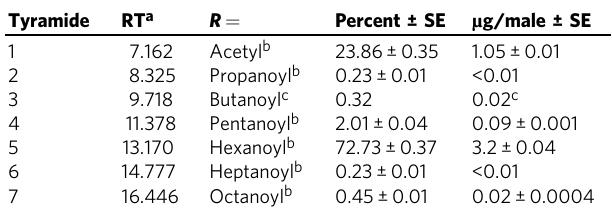
Qualitative GC retention time (RT) data are shown for the seven identi fi ed tyramides. Quantitation ( μ g/male) for tyramide components 1, 2, 4, 5, 6, and 7 from GC-MS analyses of external genitalia complex extracts ( n = 13 independent external genitalia complex samples) were obtained usingn-butanoyl tyramide as a relative internal standard. Peak assignments were based on fragmentation pattern, retention time, and standards (THJ 20 ). The percent of n-butanoyl tyramide of the 7 tyramides was determined from a single sample of fi ve pooled male reproductive systems using the octanoyl tyramide (synthesized by THJ 20 ) as the External Standard (ES). Percent composition was based on the values in the µ g/male column. See Fig. 1a for the GC-MS chromatogram pro fi le. a Retention time. b From Internal Standard method, n = 13. c From External Standard